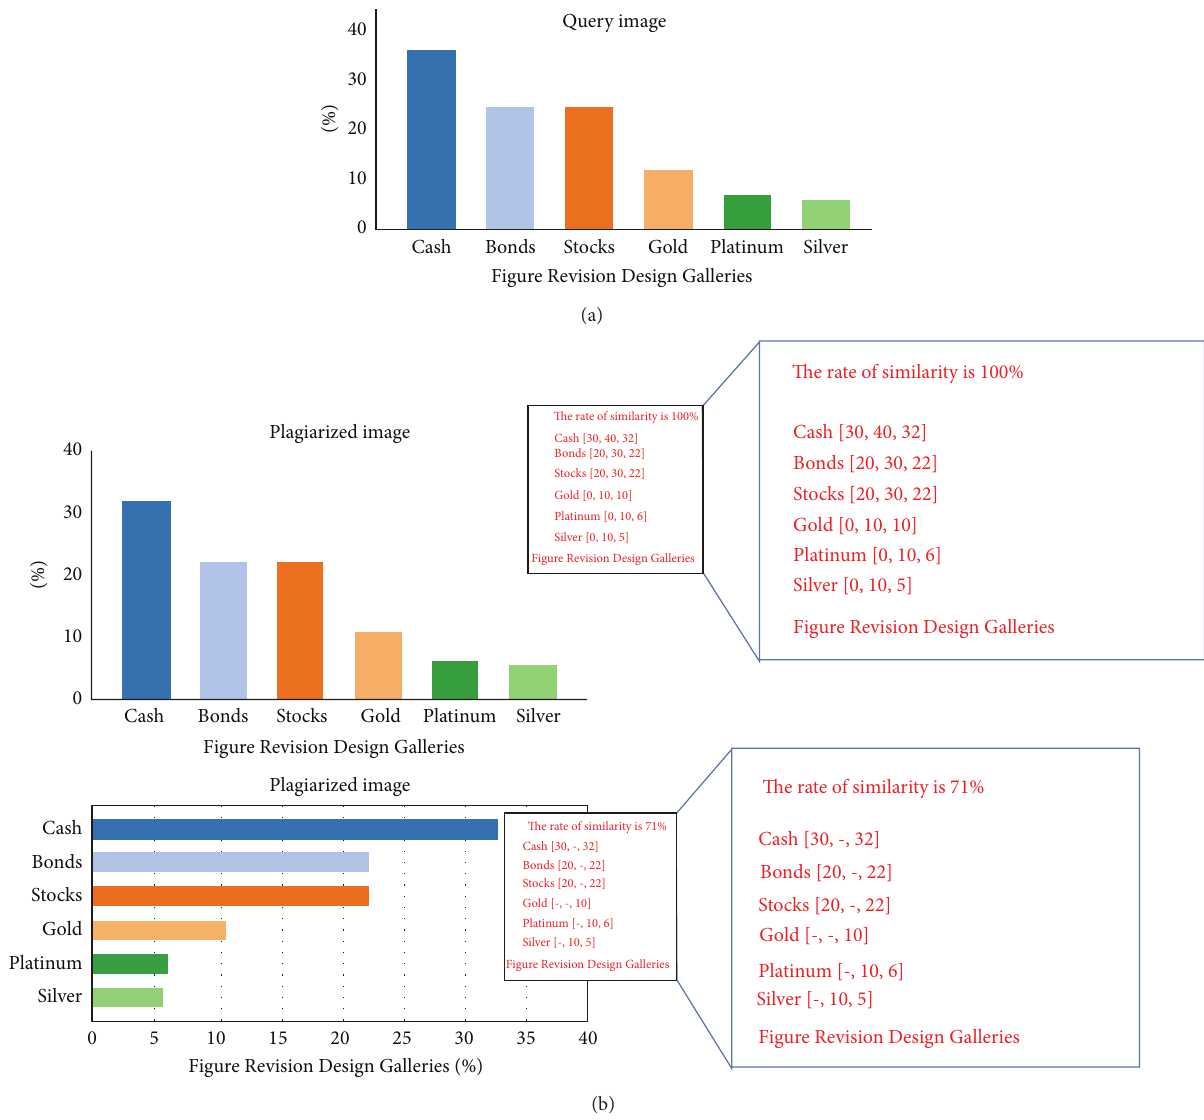
Figure 6: Plagiarism detection for one of Exact Copy patterns as plagiarism of the whole data of